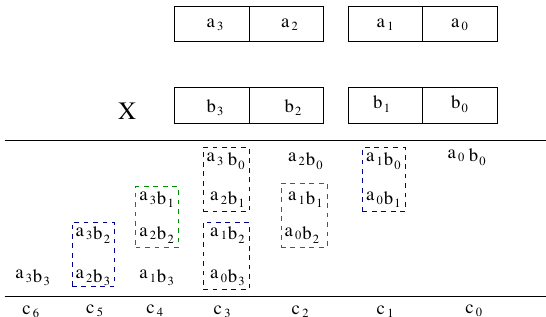
Figure 1: Reducing the number of multiply-and-accumulate instructions in schoolbook